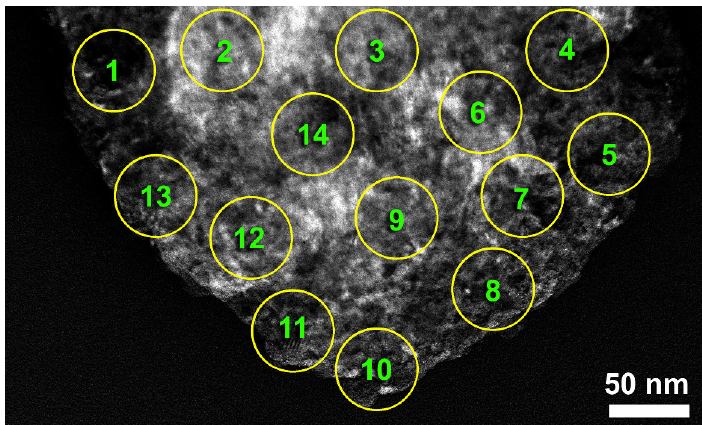
Figure 2. Dark field image (DFI) of nanocomposite MgH 2 /5 wt% (2.5 ZrNi 5 /2.5 Nb 2 O 5 ) powders obtained after milling for 50 h. The results of EDS analysis for the zones indexed in the figure are presented in Table